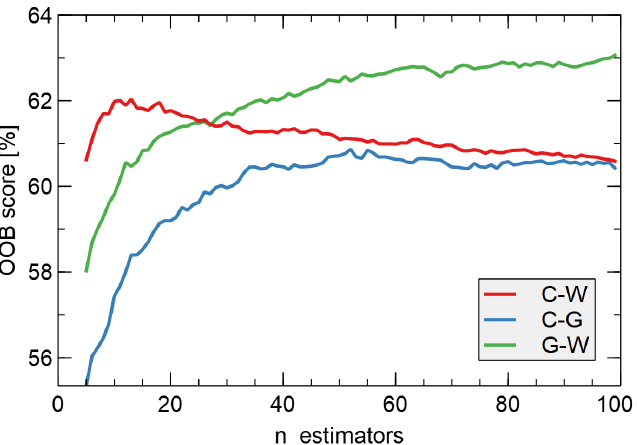
Figure 10. Average of out-of-bag (OOB) error score (classification accuracy) versus the number of estimators used in training of the random forest classification model. Various binary models were compared: C-W–uninfected vs. white samples, C-G–uninfected vs. green samples, G-W–green vs. white samples. Since the number of observations varied between categories (Table 3), the OOB score was normalized to the case of equal populations in the classified categories.